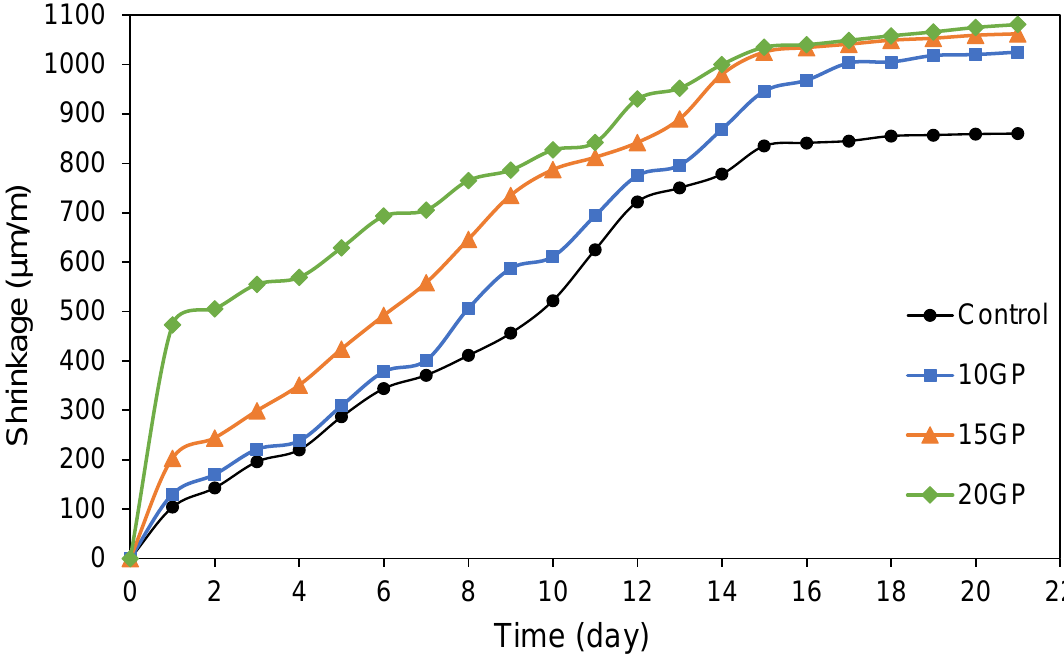
Figure 9. E ff ect of GP on total shrinkage of mortar as a function of Figure 9. Effect of GP on total shrinkage of mortar as a function of time.